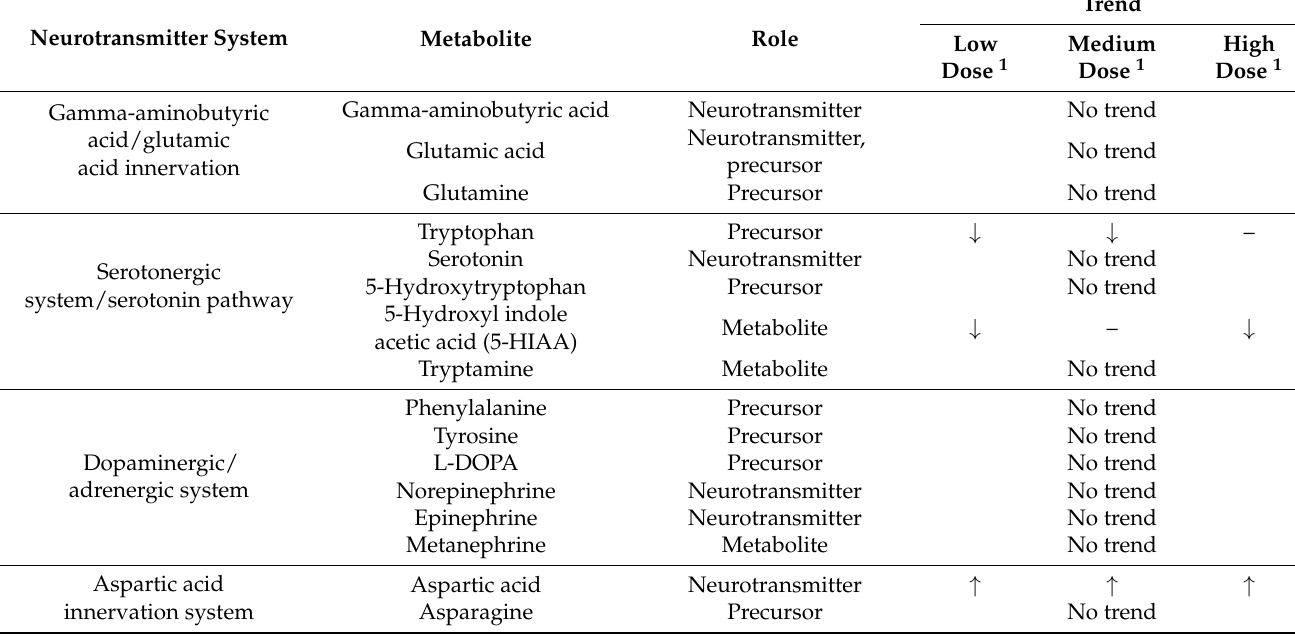
Table 2. Summary of the main findings for the targeted metabolites associated with neurotransmission.